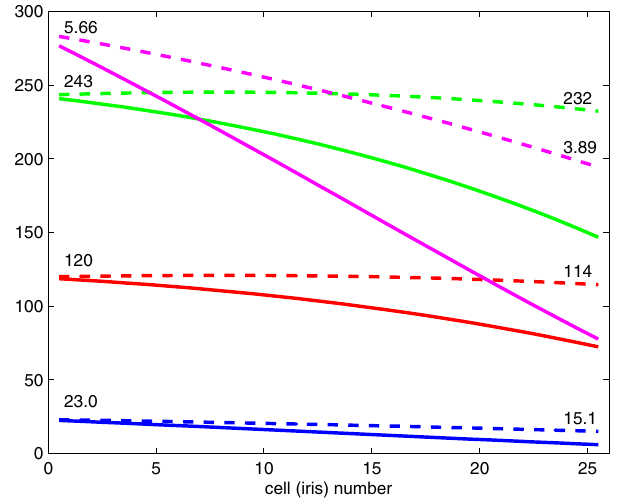
FIG. 17. The rf parameters of CDS-C: red is accelerating gradient ( MV = m ), green is maximum surface electrical field ( MV = m ), blue is pulsed temperature rise (K), and magenta is 50 times maximum modified Poynting vector: Sc (cid:8) 50 ( MW = mm 2 ) [13]. Dashed traces are unloaded and solid are beam loaded conditions.